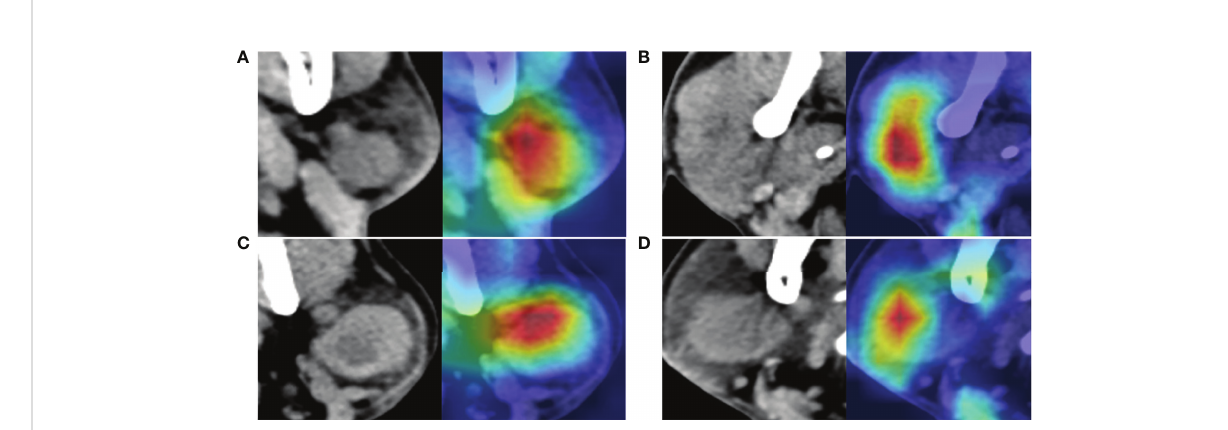
FIGURE 6 The images at the left side are the original computed tomography (CT) images; the images at the right side are the heatmaps drawn by class activation map (CAM). The red color shows where the network is focused to differentiate benign and malignant parotid tumor. (A) Is a benign tumor with homogeneous density and well-de fi ned margin, network mainly focused on the texture and margin of tumor. (B) Is a malignant tumor with heterogeneous density and poor-de fi ned margin, network mainly focused on the texture of tumor. (C) Is a benign tumor with intra- tumoral cystic component and well-de fi ned margin, whereas network mainly focused on the upper part of the tumor and the margin of the tumor but not the intra-tumoral cystic component. (D) Is a malignant tumor with homogeneous density and relative well-de fi ned margin, network mainly focused on texture of the left part of tumor but not the margin of tumor. All these tumors are correctly recognized by the neural network.